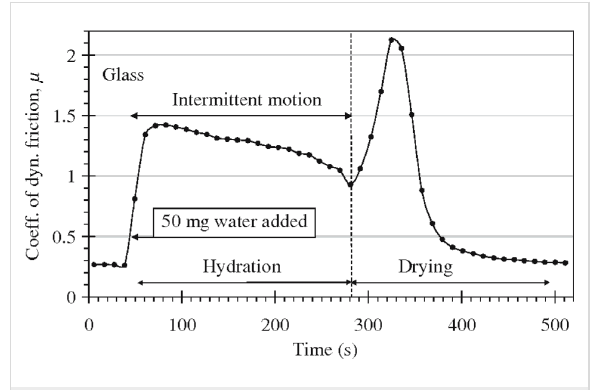
Figure 7: The friction coefficient of skin for a glass ball ( R = 0.8 cm) at a sliding velocity of 0.8 cm/s and a normal load of 0.5 N during wetting/ drying. Adopted from [3] with the permission of the authors.